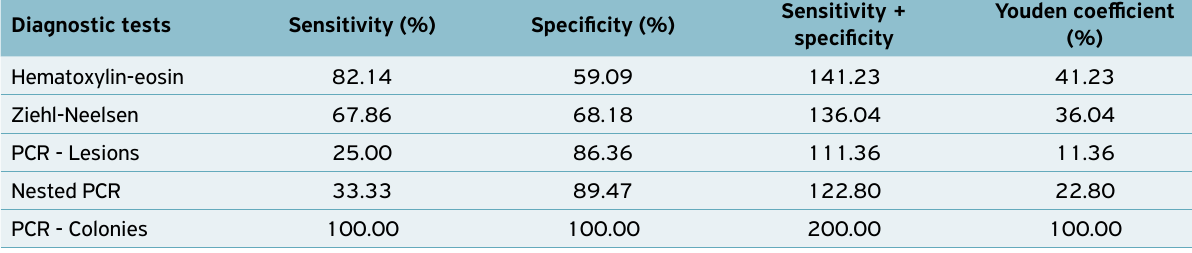
Table 4. Sensitivity, specificity and Youden coefficient of diagnostic tests analyzed versus bacterial